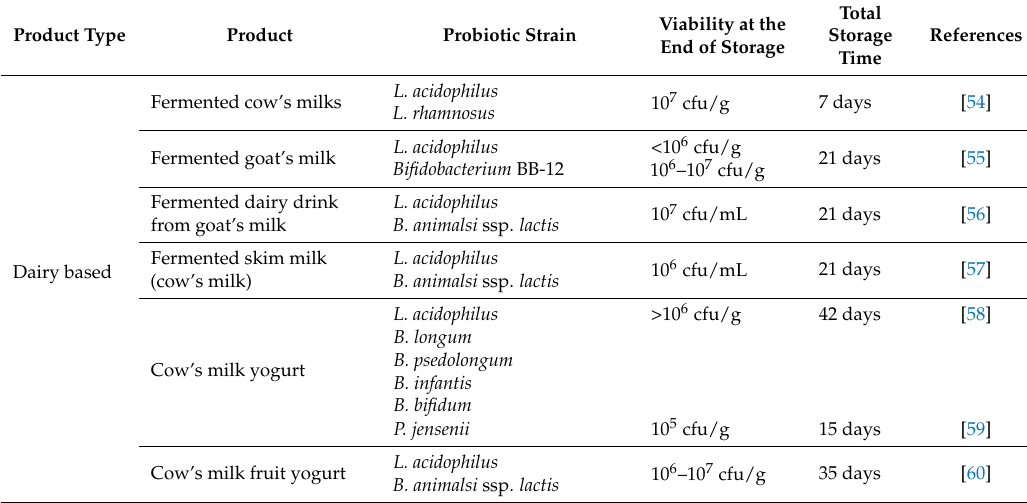
Table 4. The diversity of probiotic food products and the viability of each probiotic in different products at the end of appropriate storage conditions (either freeze or cold